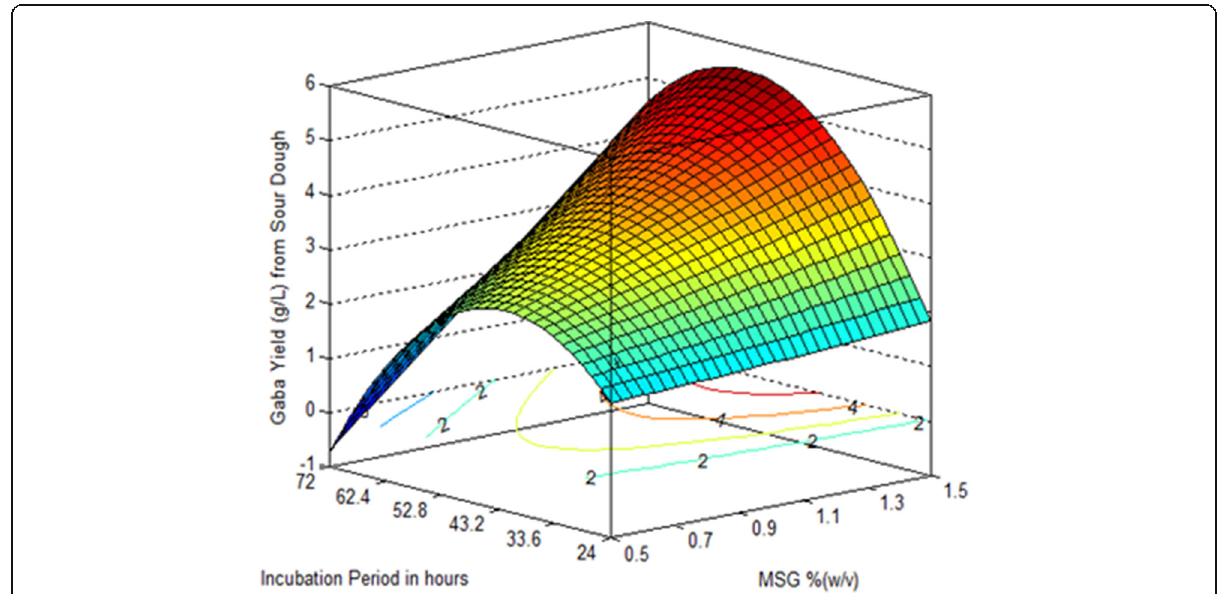
Fig. 6 3D plot for interactive effect of MSG concentration and incubation period on the GABA yield (g/L) by Lb . fermentum keeping glucose concentration at its constant central level (0)